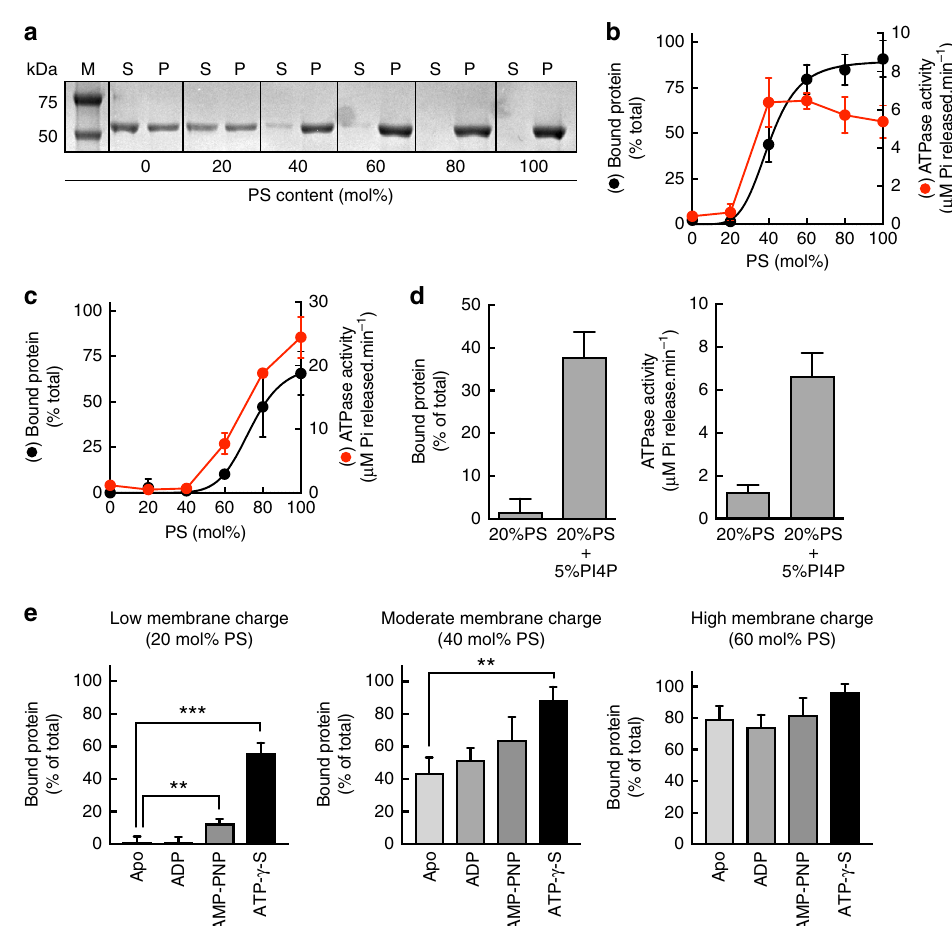
Fig. 2 Membrane binding and ATPase activity of EHD1. a Representative gel showing results from a sedimentation assay with EHD1 added to liposomes of increasing PS content and spun down to separate the supernatant (S) and pellet (P) fractions. M denotes the marker lane. b Bound fraction and ATPase activity of EHD1 with liposomes of increasing PS content. Data represent mean ± SD for N = 3. c Bound fraction and ATPase activity of EHD1(F322A) with liposomes of increasing PS content. Data represent mean ± SD for N = 3. d Bound fraction and ATPase activity of EHD1 on liposomes of the indicated compositions. Data represent mean ± SD for N = 3. e Liposome-bound fraction of EHD1 with increasing PS with different nucleotides (mean ± SD, N = 3 for Apo, N = 3 for ADP, N = 3 for AMP-PNP, N = 5 for ATP- γ -S). Statistical signi fi cance was assessed using an unpaired two-tailed t -test and ** P = 0.003, *** P =